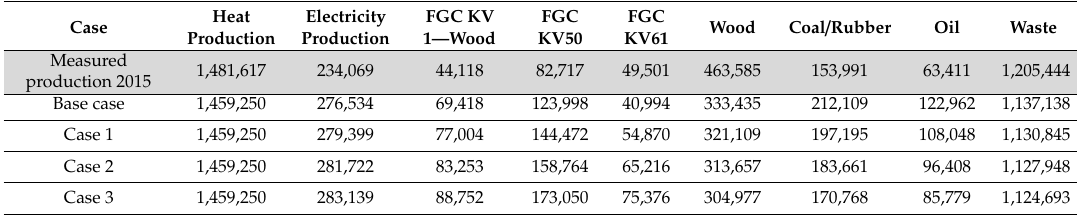
Table 8. Model results, production, and fuel use for all cases. The grey field presents measured production from 2015. All numbers in